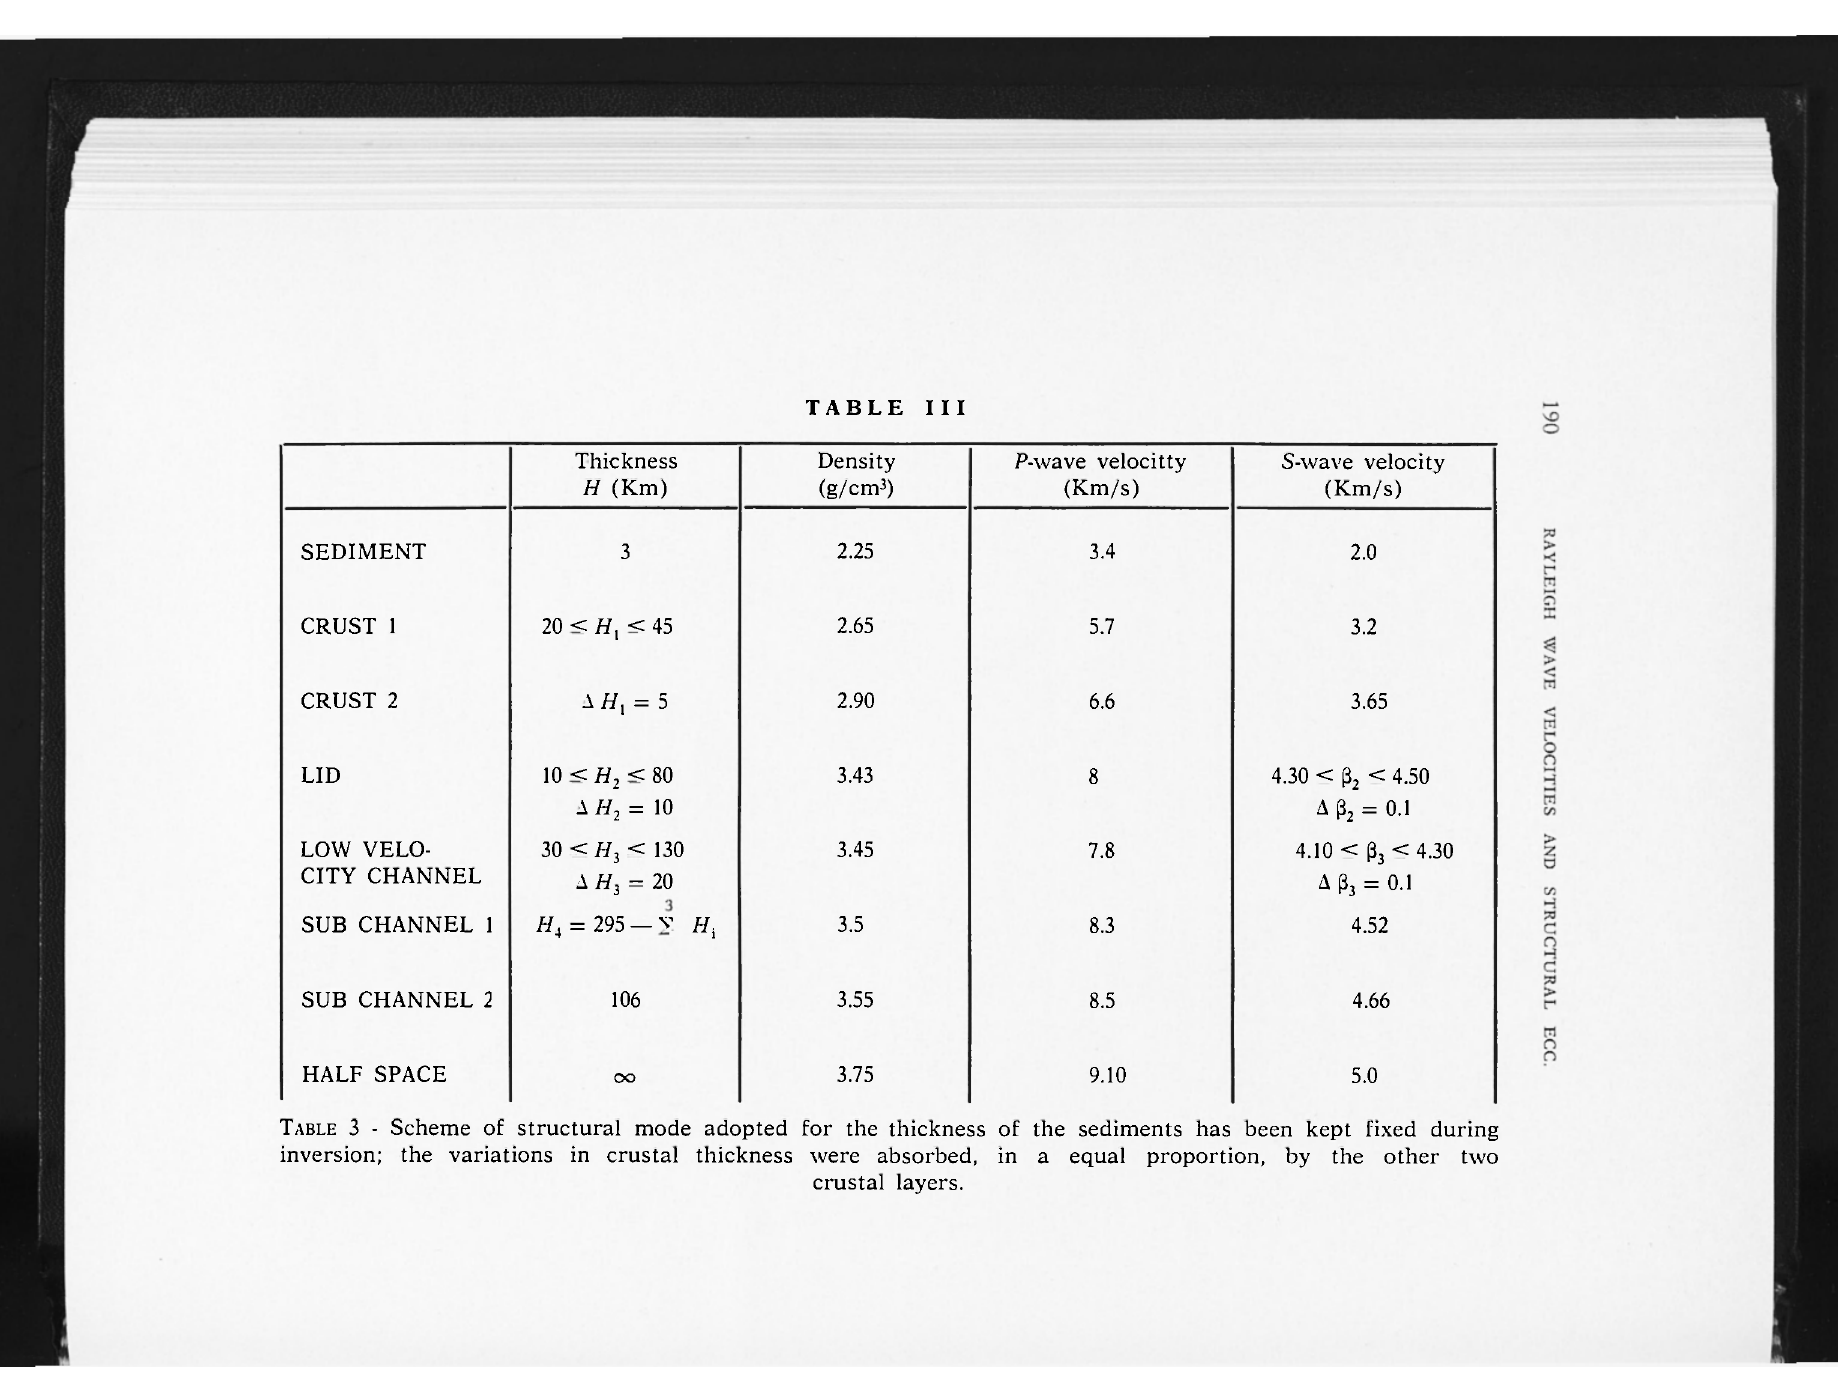
TABLE 3 - Scheme of structural mode adopted for the thickness of the sediments has been kept fixed during inversion; the variations in crustal thickness were absorbed, in a equal proportion, by the other two crustal